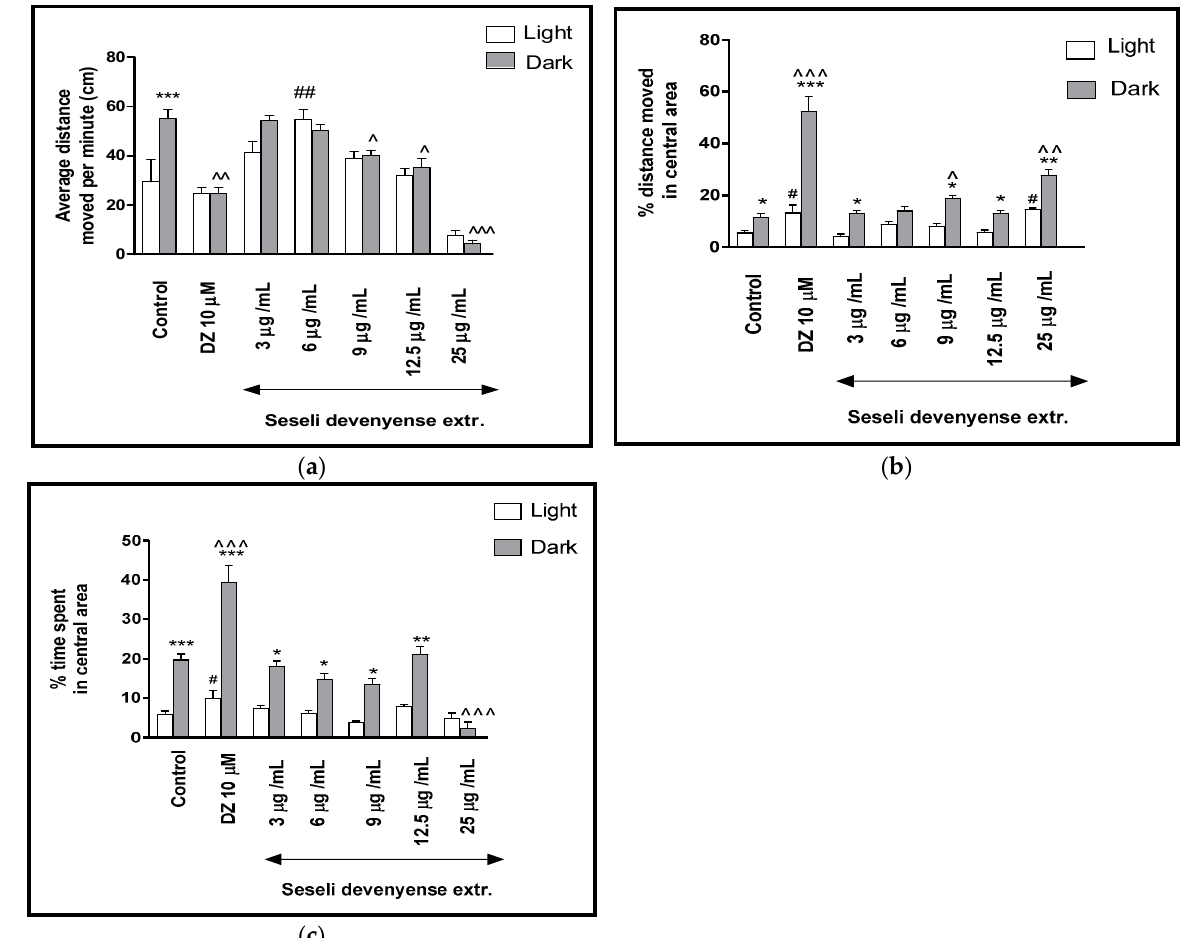
Figure 2. The effects of SDMFE (3, 6, 9, 12.5, 25 µg/mL) and diazepam (DZ, 10 µM) on locomotor activity during all three light–dark challenge phase. ( a ) Average distance moved by zebrafish larvae within each 1-min time bin under either light (open bars) or dark (filled bars); ( b ) The percentage of distance moved by zebrafish larvae in the central area during light phase (white bars) or dark phase (filled bars); ( c ) The percentage of time spent by zebrafish larvae in the central area during light phase (white bars) or dark phase (filled bars). Data are presented as mean ± SEM; n = 32. * p < 0.05, ** p < 0.01, *** p < 0.001 in comparison to light conditions within the same concentration group; ^ p < 0.05, ^^ p < 0.01, ^^^ p < 0.001 in comparison to control group under dark condition; # p < 0.05, ## p < 0.01 in comparison to control group under light condition (post hoc Bonferroni’s test).